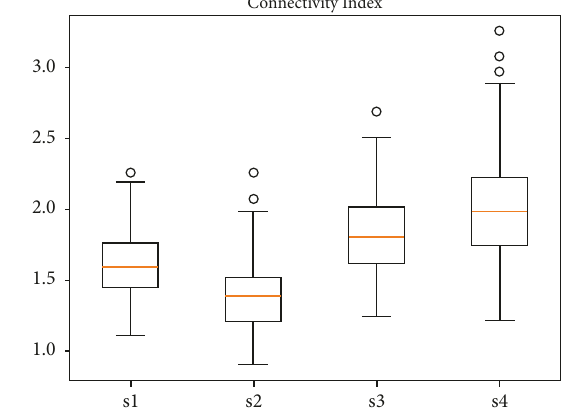
Figure 5: Comparison of strategies ( 𝑡ℎ 𝑠𝑡𝑟𝑜𝑛𝑔−𝑡𝑖𝑒 = 5 ): average connectivity of vehicles averaged across 100 simulation runs.